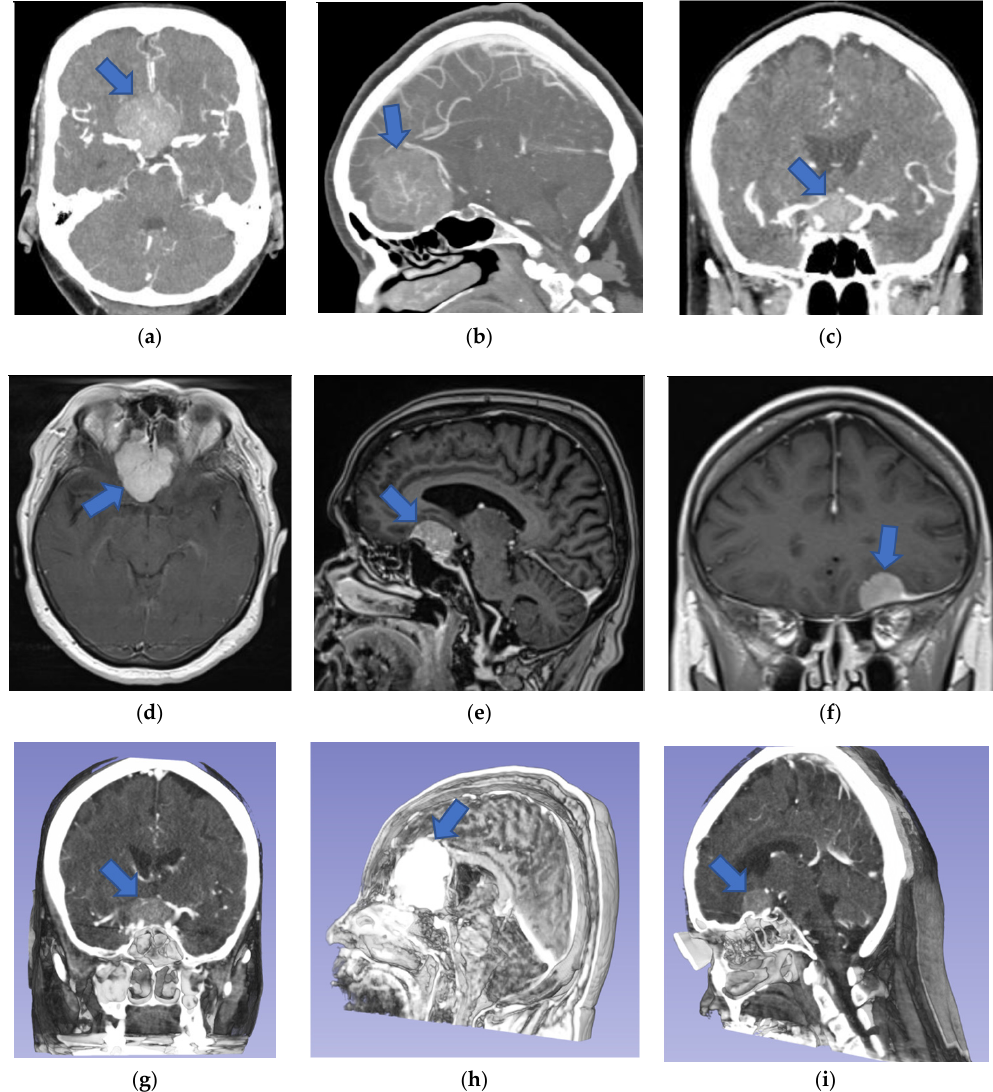
Figure 2. Preoperative 2D and screen 3D images (from CT and MRI modalities) of patients with anterior skull base meningiomas (blue arrows). ( a ) Axial 2D-CTA image presenting planum sphenoidale meningioma. ( b ) Sagittal 2D-CTA image presenting olfactory groove meningioma. ( c ) Coronal 2D-CTA image presenting tuberculum sellae meningioma. ( d ) Axial 2D-MRI image presenting olfactory groove meningioma. ( e ) Sagittal 2D-MRI image presenting anterior clinoidal meningioma. ( f ) Coronal 2D-MRI image presenting frontobasal meningioma. ( g ) Coronal screen 3D-CT image presenting tuberculum sellae meningioma. ( h ) Sagittal screen 3D-MRI image presenting olfactory groove meningioma. ( i ) Sagittal screen 3D-CT image presenting anterior clinoidal meningioma. 2D, two-dimensional; 3D, three-dimensional; CT, computed tomography; CTA, computed tomography angiography; MRI, magnetic resonance imaging.